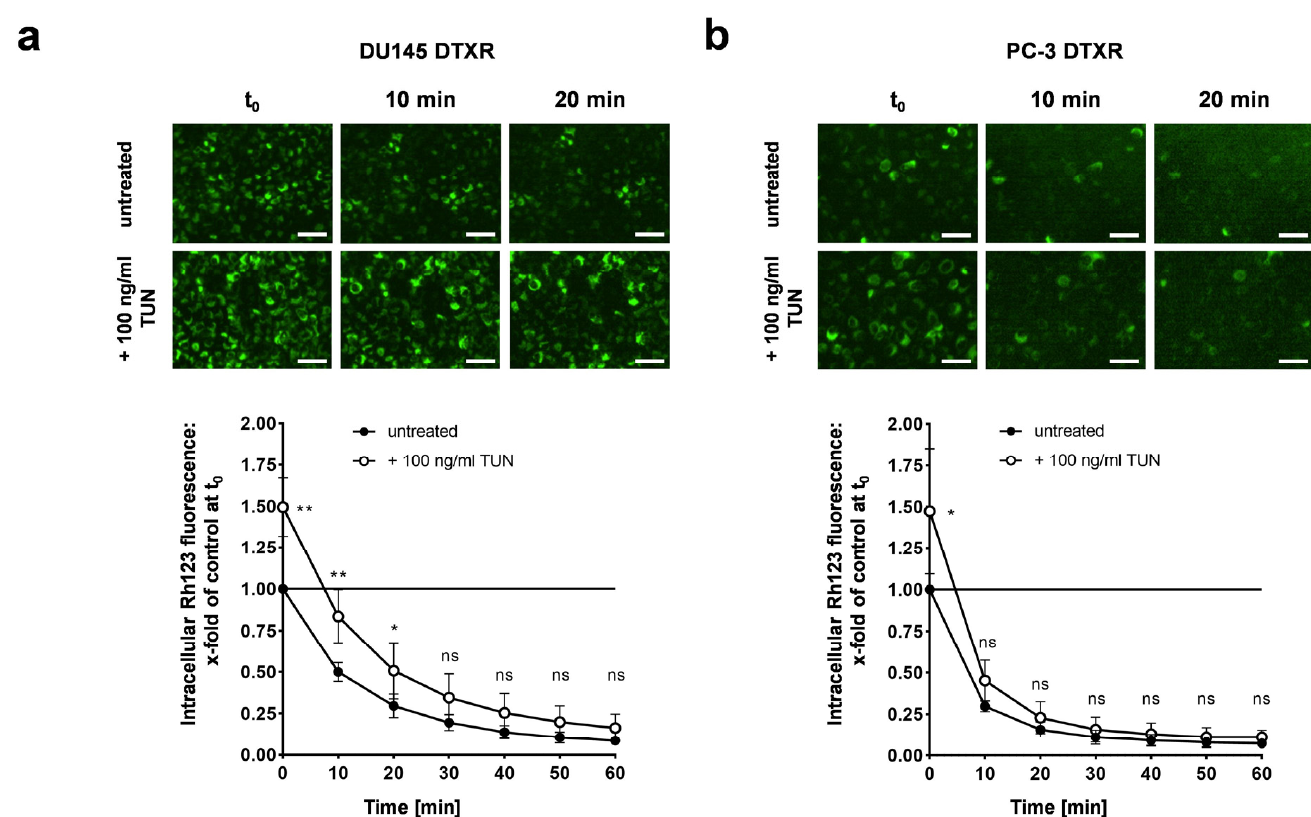
Figure 6. Influence of the glycosylation status of ABCB1 protein on ABCB1 efflux activity of the fluorescent ABCB1 substrate Rh123 in DU145 and PC-3 DTXR cells. ( a ) DU145 and ( b ) PC-3 DTXR cells with or without pre-treatment with 100 ng/mL tunicamycin (TUN) for 96 h were incubated with 0.5 µg/mL Rh123 for 15 min. After several washing steps, RPMI 1640 medium was added and subsequently the cells were imaged in 10 min intervals. As examples, the first image (t 0 ) and images taken after 10 and 20 min are depicted for DTXR cells with or without tunicamycin pre-treatment (scale bar 50 µm). Longitudinal data were normalized to DTXR cells without tunicamycin pre- treatment at t 0 (black line in the graph). Data are depicted as mean ± SD of four to five independent biological replicates. Non-paired t-test with Welch’s correction was performed for comparison of DTXR cells with tunicamycin pre-treatment vs. DTXR cells without tunicamycin pre-treatment at each timepoint: * p < 0.05, ** p < 0.01, ns: not significant.